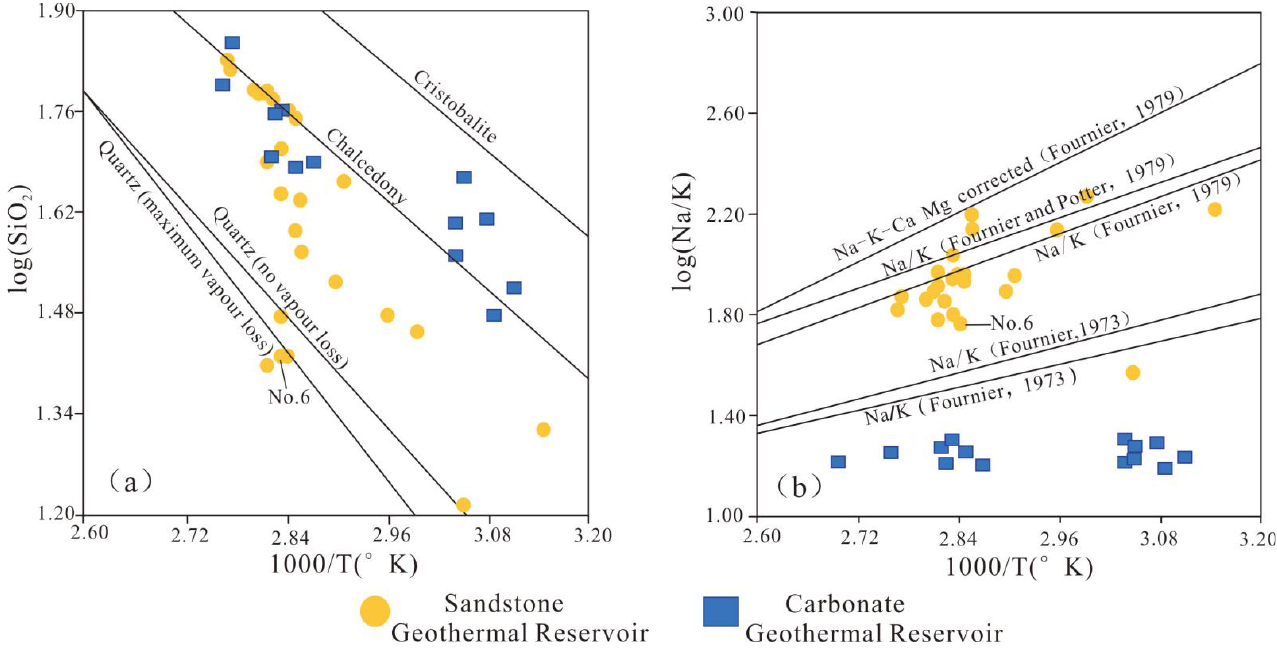
Figure 6. Diagram of ( a ) SiO2 and ( b ) Na/K at 1000/T for geothermal fluids.